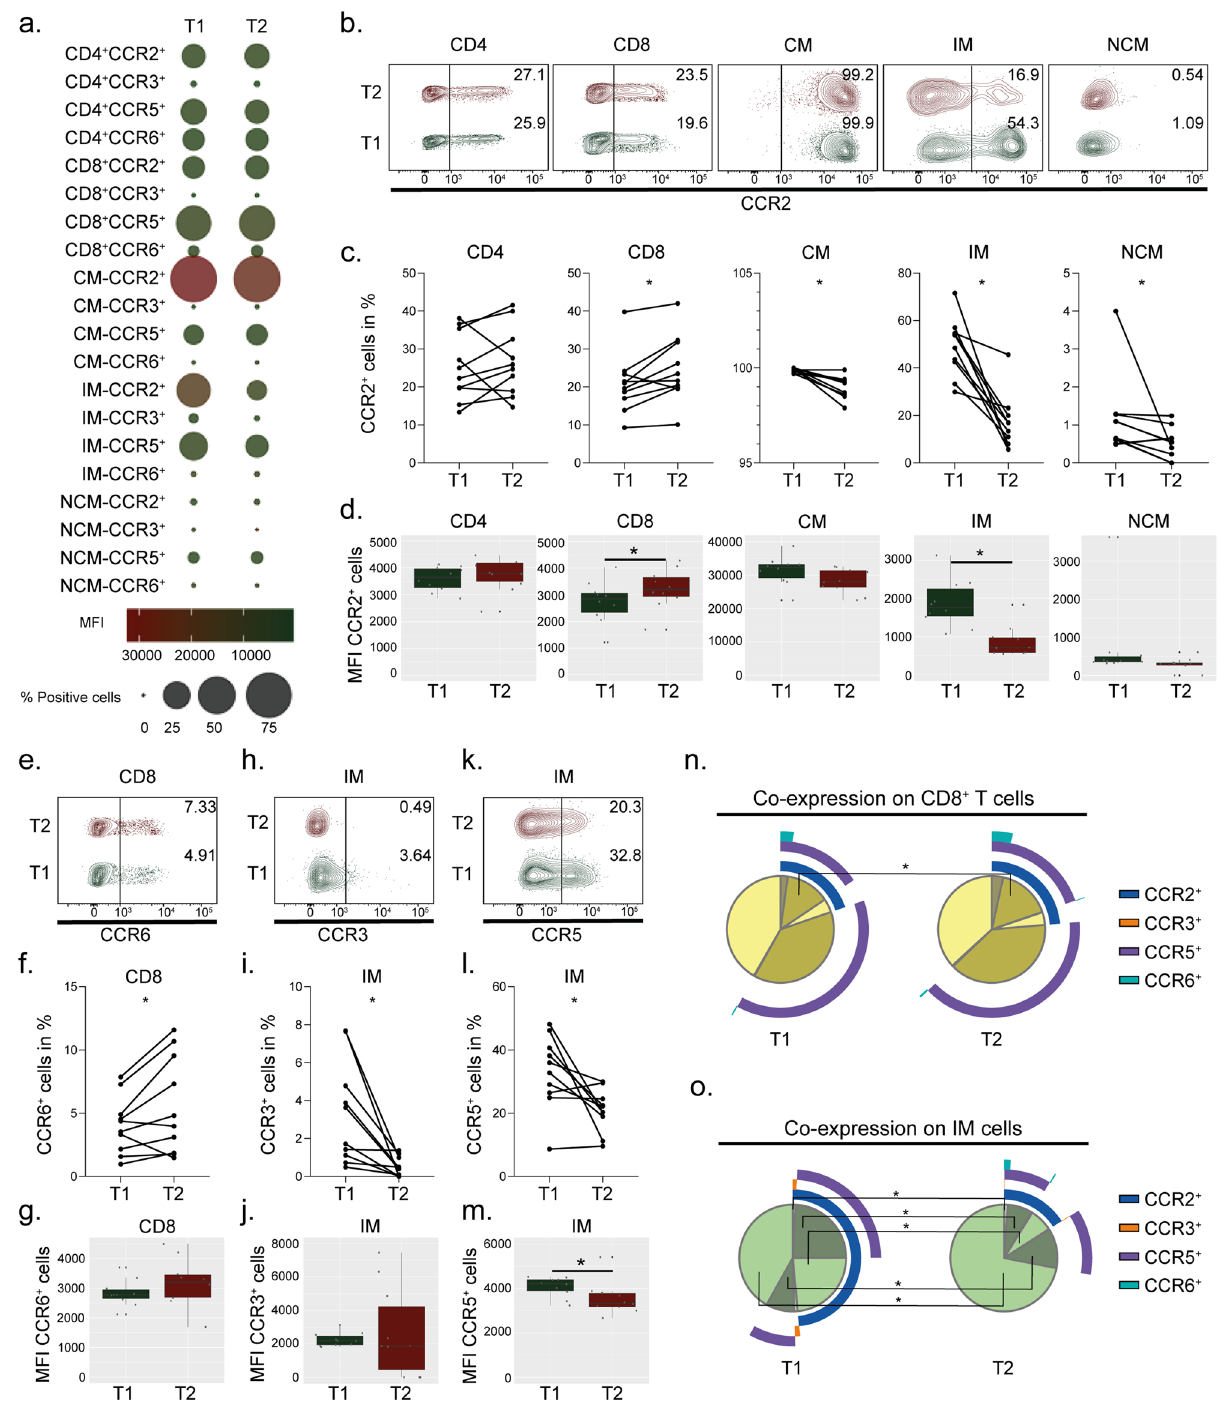
Fig. 3 In time, CCR2 and CCR6 increase on CD8 cells while CCR2 decreases on monocytes in PLWH ART . Receptor expression of longitudinal data on lymphocytes and monocytes at arbitrary timepoint 1 (T1) ( n = 10) and three years later at timepoint 2 (T2) ( n = 10) from total peripheral blood mononuclear cells. a Bubble chart representing receptor expression of CCR2, CCR3, CCR5 and CCR6 on CD4 + and CD8 + T cells together with classical (CM; CD14 + CD16 − ), intermediate (IM; CD14 + CD16 + ), and non-classical (NCM; CD14 − CD16 + ) monocytes. Size of the bubble corresponds to percentage-positive cells while colour represents the median fl uorescent intensity (MFI). b , c Receptor expression of CCR2 on CD4 + , CD8 + , CM, IM and NCM. d MFI of CCR2 on CD4 + , CD8 + , CM, IM and NCM. e , f Receptor expression of CCR6 on CD8 + T cells. g MFI of CCR6 on CD8 + T cells. h , i Receptor expression of CCR3 on IM. j MFI of CCR3 on IM. k , l Receptor expression of CCR5 on IM. m MFI of CCR5 on IM. n , o Co-receptor expression of CCR2, CCR3, CCR5 and CCR6 on CD8 + T cells ( n ) and IM ( o ). b , e , h , k Contour plot shows a representing sample from T1 and T2 corresponding to the median % of cells within each group. c , d , f , g , i , j , l – o Statistical signi fi cance was determined using two-tailed Wilcoxon matched-pairs signed-rank test (signi fi cance level p < 0.05, with *<0.05, **<0.001) and represented as paired before and after plot, median using 95% CI or as pie